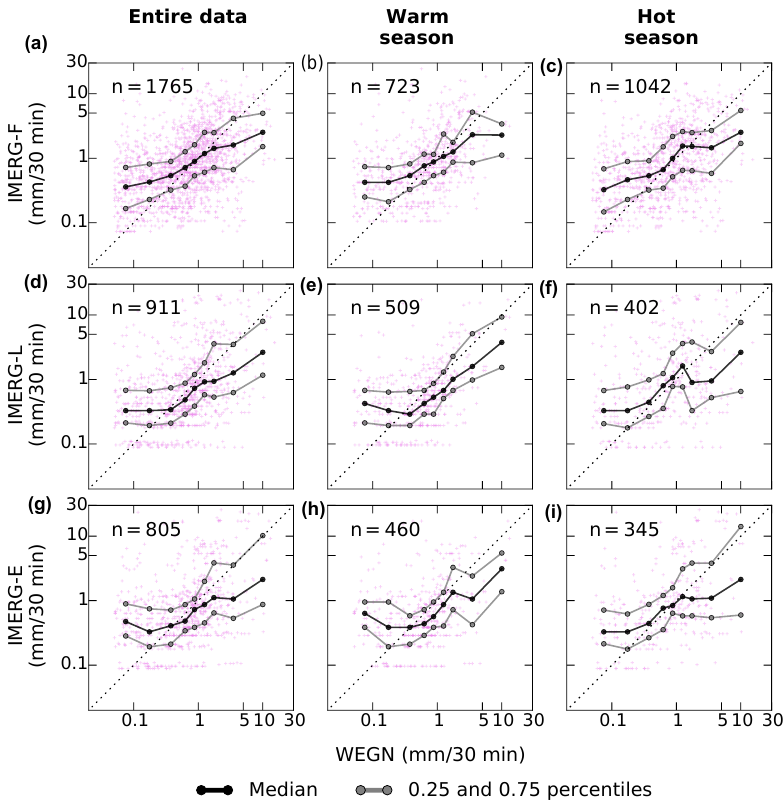
Figure 6. Scatter plots of half-hourly rainfall amounts for IMERG-F (a–c) , IMERG-L (d–f) , and IMERG-E (g–i) versus WEGN, for the entire dataset (a, d, g) , warm season only (b, e, h) , and hot season only (c, f, i) . Overplotted are, for nine bins across the range with at least 30 IMERG-WEGN data pairs in each bin, the 50th percentile (black symbols and line) and the 25th and 75th percentiles (gray symbols and lines) of the IMERG estimates. Total number of data pairs ( n ) is indicated in the upper left of each panel. Note that a log-log scale is